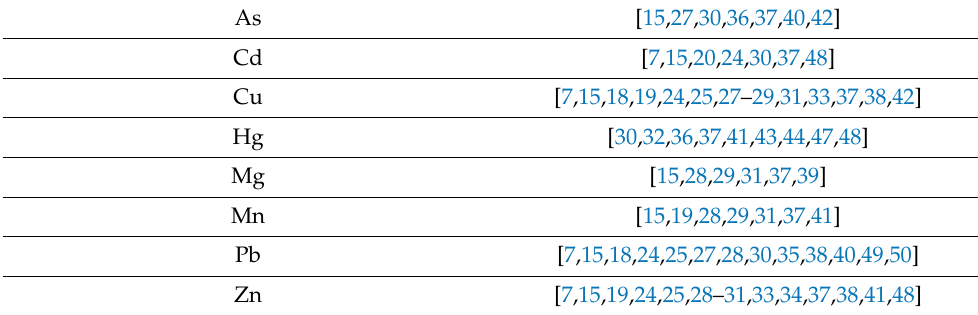
Table 4. Metals considered by author: most frequently analyzed.